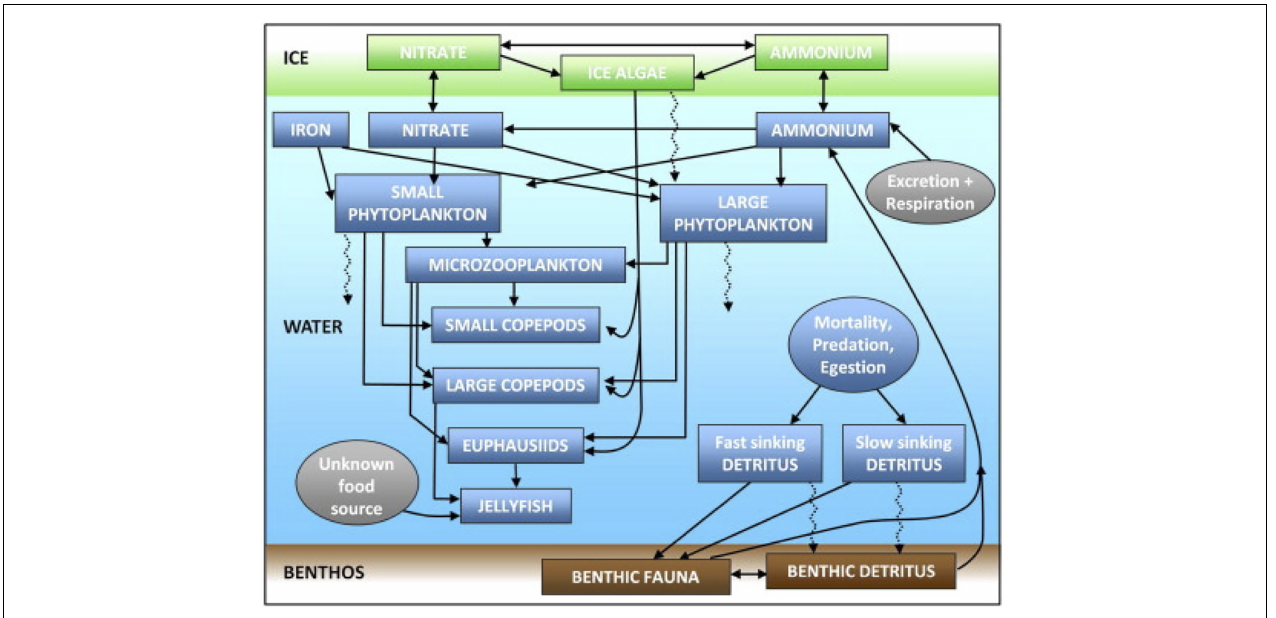
FIGURE 2 | Schematic diagram of the model ecosystem structure, reprinted from Gibson and Spitz (2011) with permission from Elsevier.